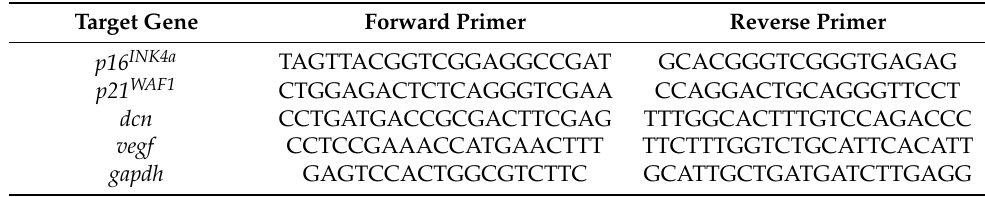
Table 1. Primer sequences (5 (cid:48) → 3 (cid:48)